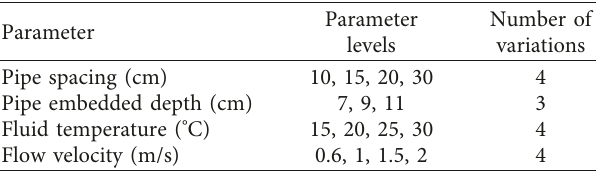
Table 2: Design parameters of pipe